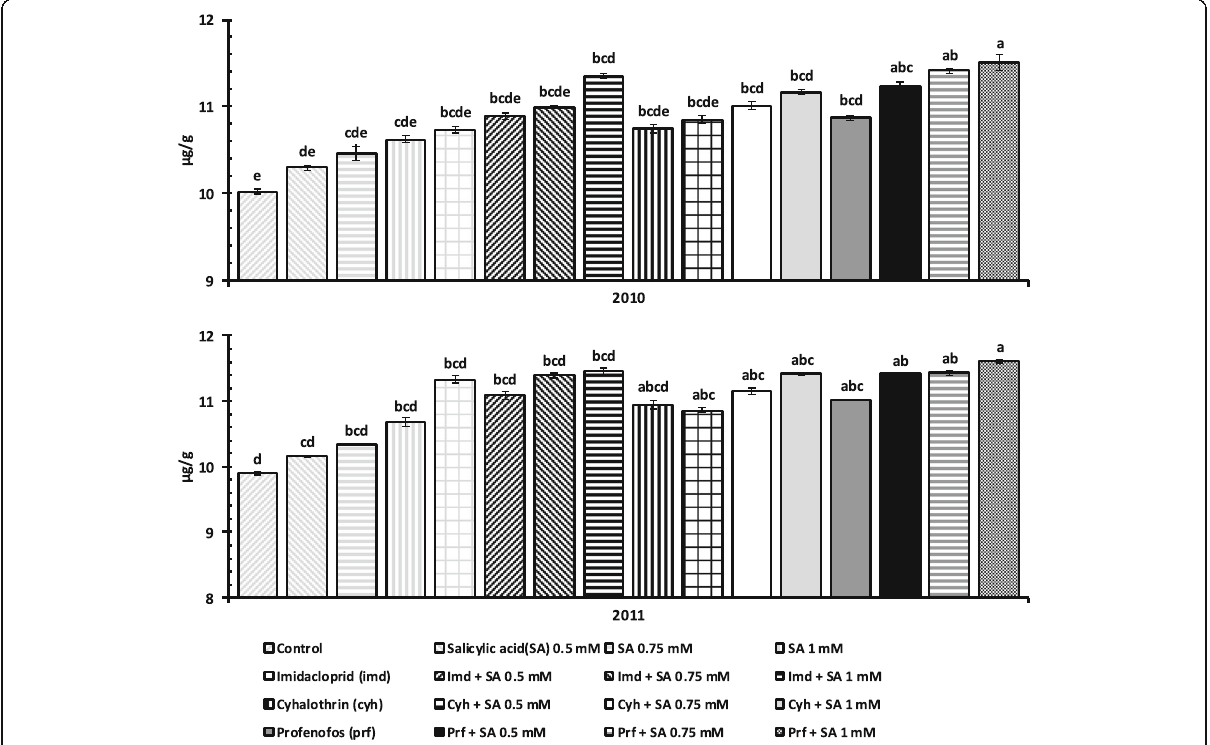
Fig. 3 Effect of certain insecticides and/or SA combination on total phenolic compounds in cotton leaves ( μ g/g phenolic